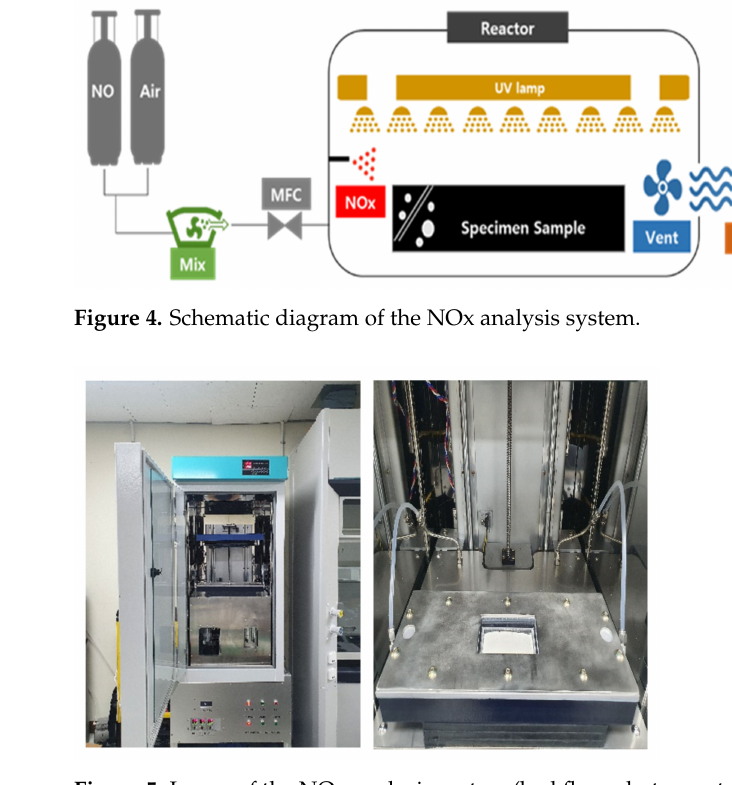
Figure 5. Image of the NOx analysis system (bed flow photo reactors).